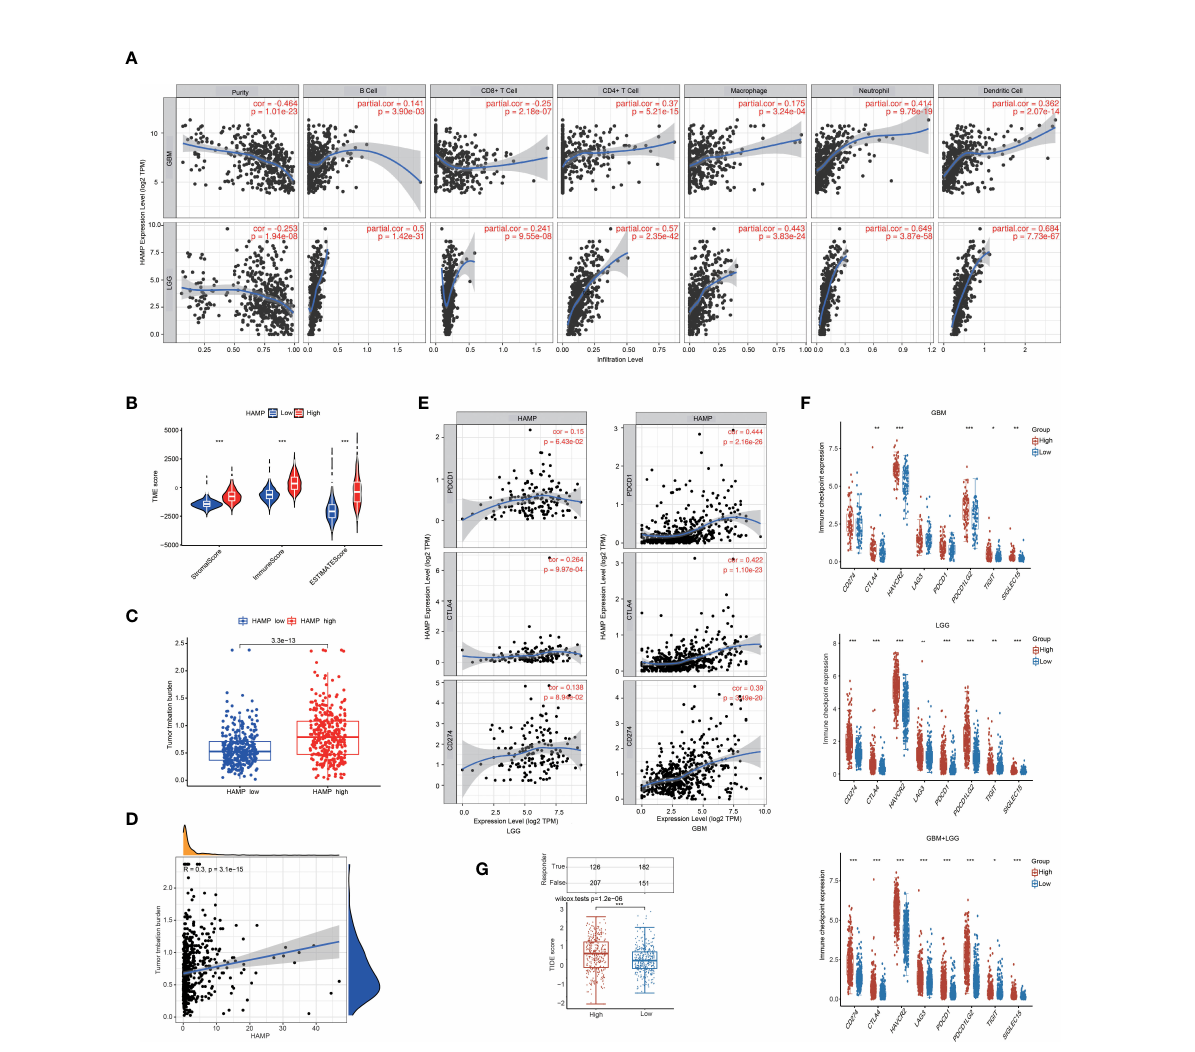
FIGURE 8 Analysis of the correlations between hepcidin expression and immune cell in fi ltration and immunotherapy. (A) hepcidin is signi fi cantly associated with tumor purity and is positively correlated with the in fi ltration of different immune cells using the TIMER database. (B) The TME scores between the high and low hepcidin expression groups in the CGGA database. (C) Comparison of the TMB between the high and low hepcidin expression groups in the CGGA database. (D) The correlation between hepcidin expression and the TMB. (E) Scatterplots of the correlations between hepcidin expression and PD-1, PD-L1 and CTLA-4 expression in LGG and GBM. (F) The effect of hepcidin on the expression of immune checkpoint genes. The expression of various immune checkpoint genes between hepcidin high-expression group and hepcidin low-expression group of patients with LGG or/and GBM was examined. (G) Comparison of TIDE scores between the hepcidin high-expression group and low- expression group based on TCGA database. * p < 0.05, ** p < 0.01, and *** p <